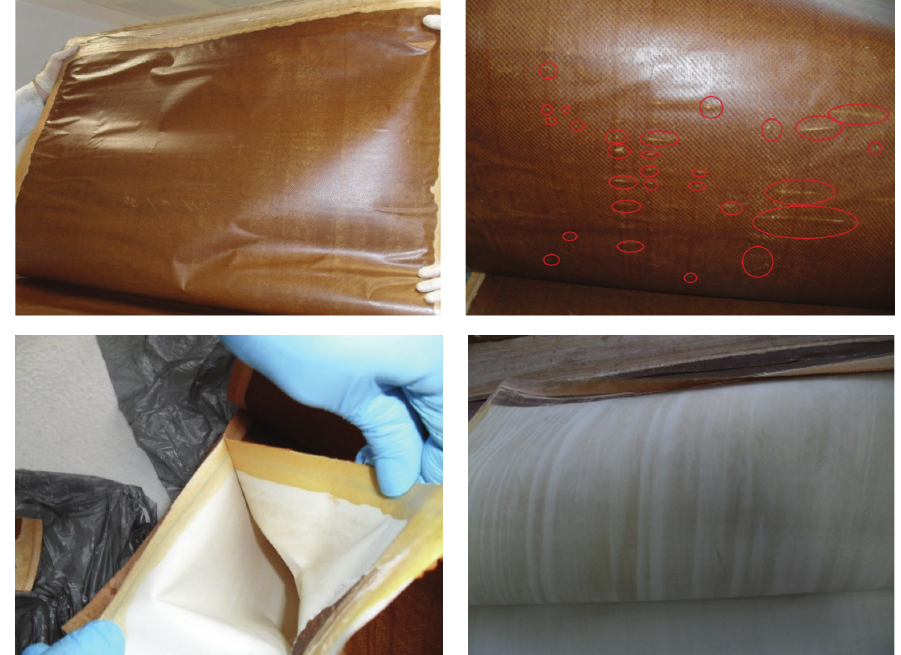
Figure 3: Membrane leaves and permeate spacer images taken during physical inspection (circles indicate surface